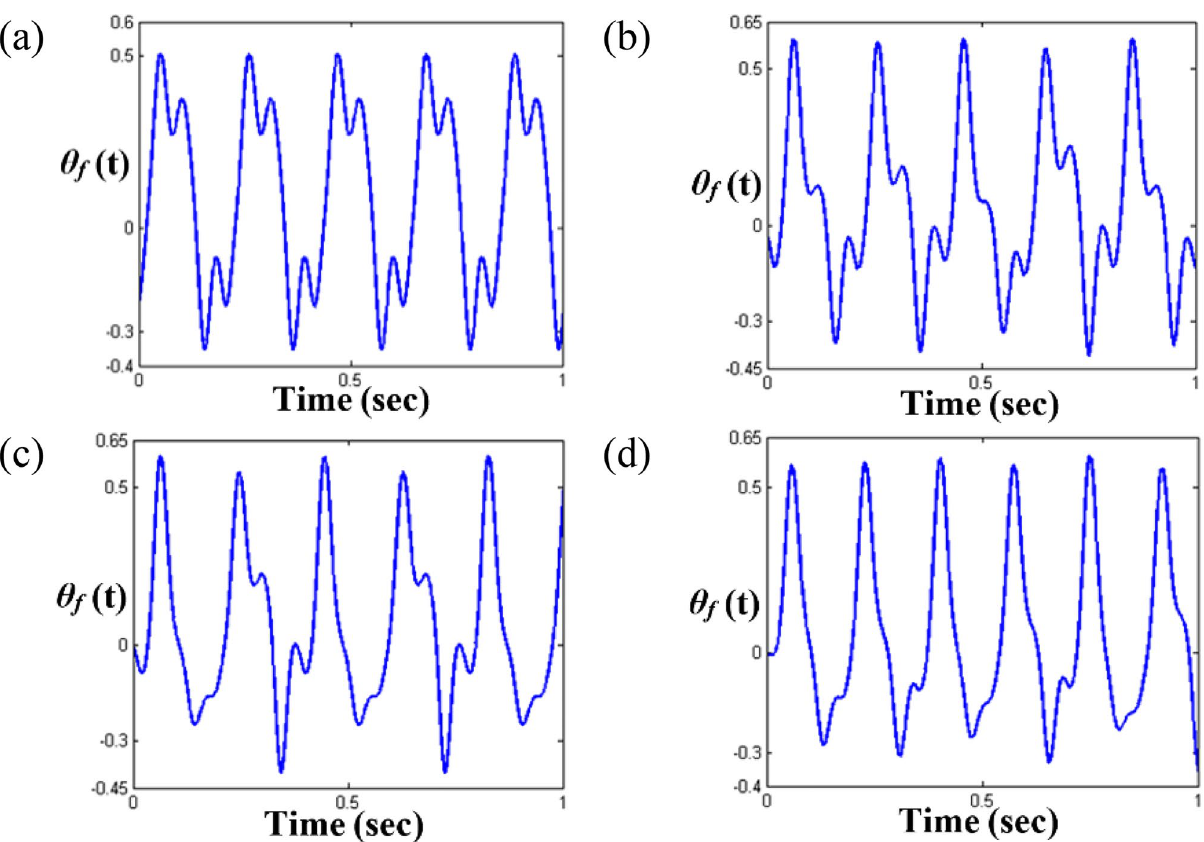
Figure 4. Comparisons of time histories calculated by NS in the super-harmonic regimes: ( a ) time history at ̟ = 0.26 ; ( b ) time history at ̟ = 0.275 ; (c) time history at ̟ = 0.285 ; (d) time history at ̟ = 0.315